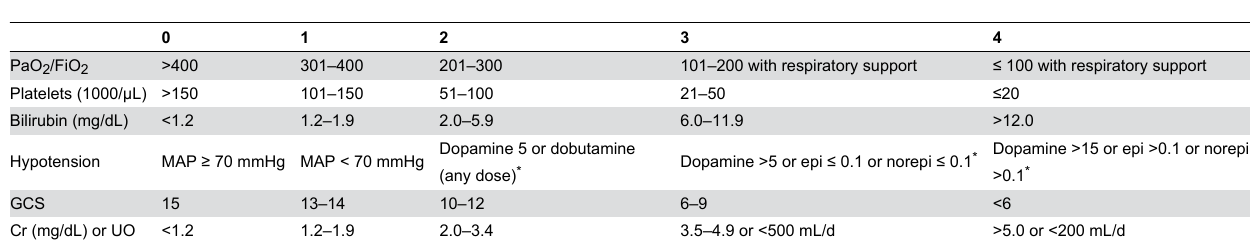
Table 1. SOFA scoring system.